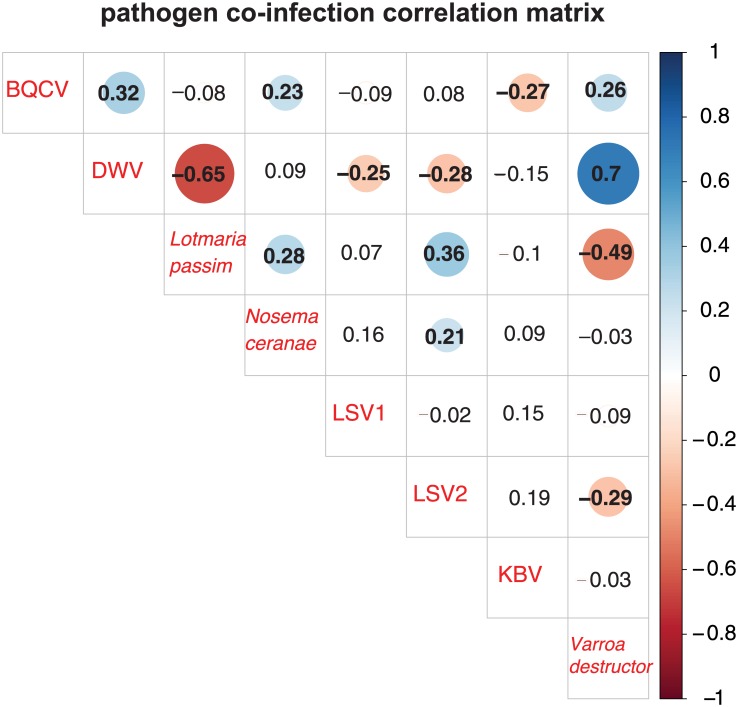
Pathogen co-infection correlation matrix.The abundance of pathogens in co-infected colonies was analyzed by calculating the correlation coefficients for each pair-wise comparison, which are listed in each cell. Correlation coefficients (reported as r values) quantify the strength and direction of the changes in pathogen abundance between pairs of pathogens. The shaded red circles represent negative correlations and blue circles represent positive correlations, darker hues and larger circles indicate stronger correlations, and bold numbers indicate significant correlations (p-value < 0.05). DWV and Varroa destructor mites had the strongest positive correlation, while DWV and L. passim displayed the strongest negative correlation.